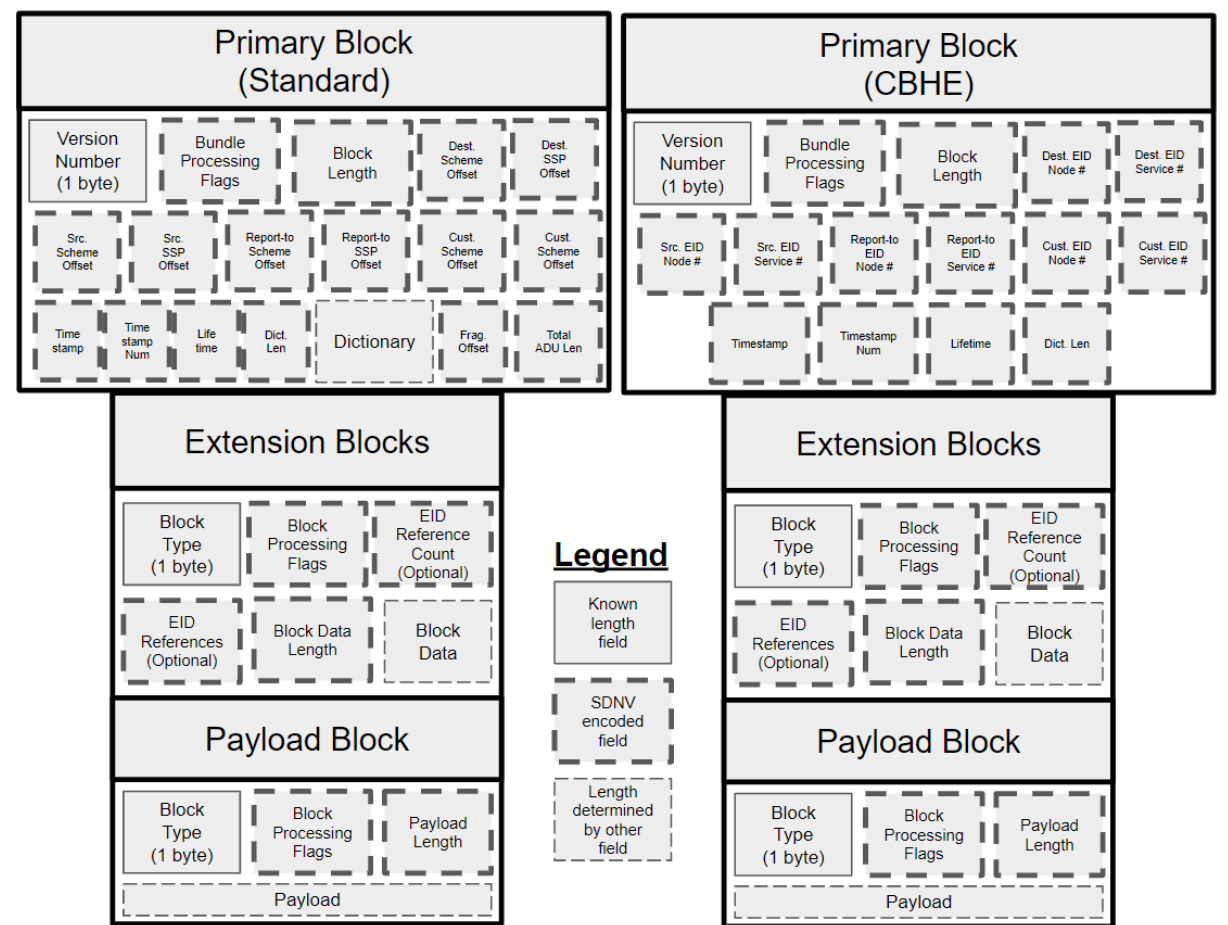
Figure 3. Layout of BPv6 bundles. Very few fields have a defined bit width (denoted with a solid outline). Most fields have a bit width that is only known until it is parsed using the SDNV encoded scheme (denoted with a bold dashed outline). Other fields have a width encoded by a field preceding it (denoted with a non-bold dashed